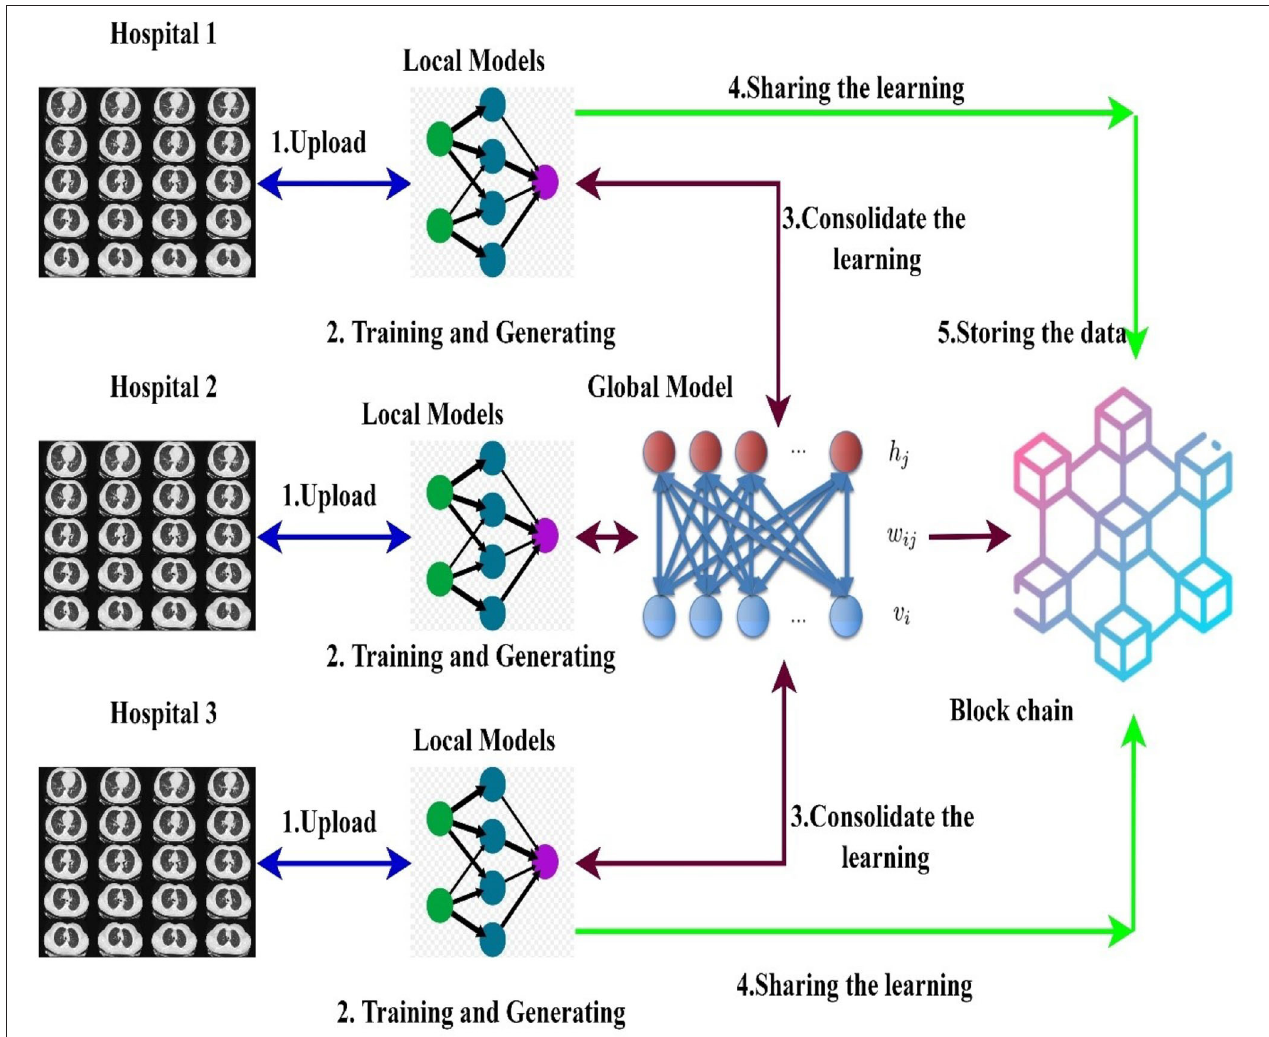
FIGURE 5 | Blockchain empowered federated learning models used in the proposed